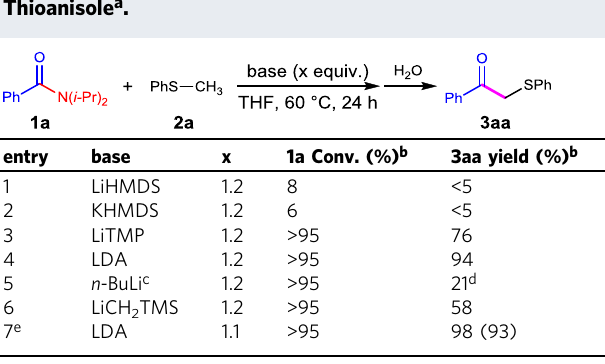
Table 1 Alkylation of N, N -diisopropylbenzamide with Thioanisole a .